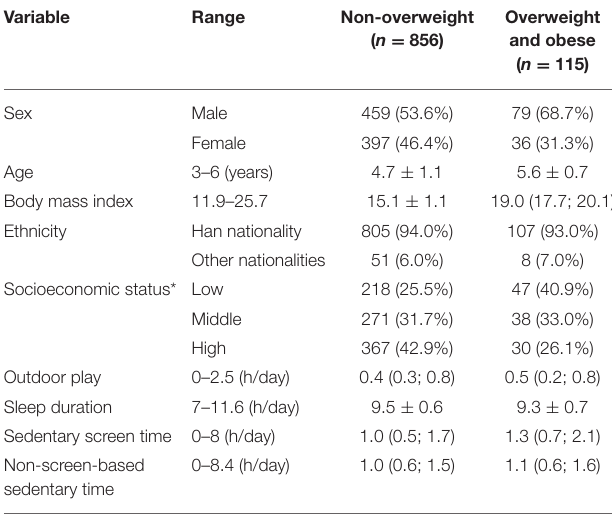
TABLE 1 | Characteristics of the study population in the PATH-CC study ( n = 971).